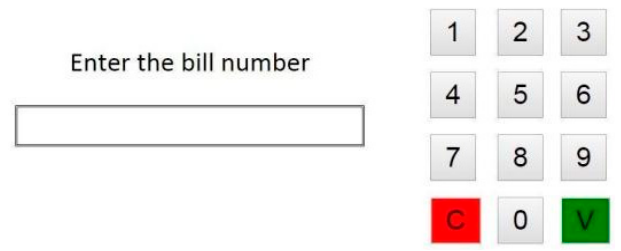
Figure 4. Money transfer app.